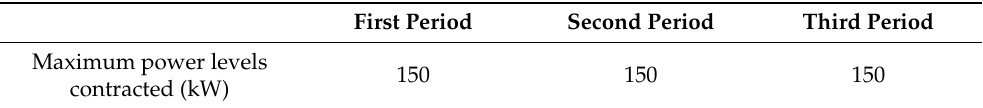
Table 1. Maximum power consumption initially contracted with the electrical